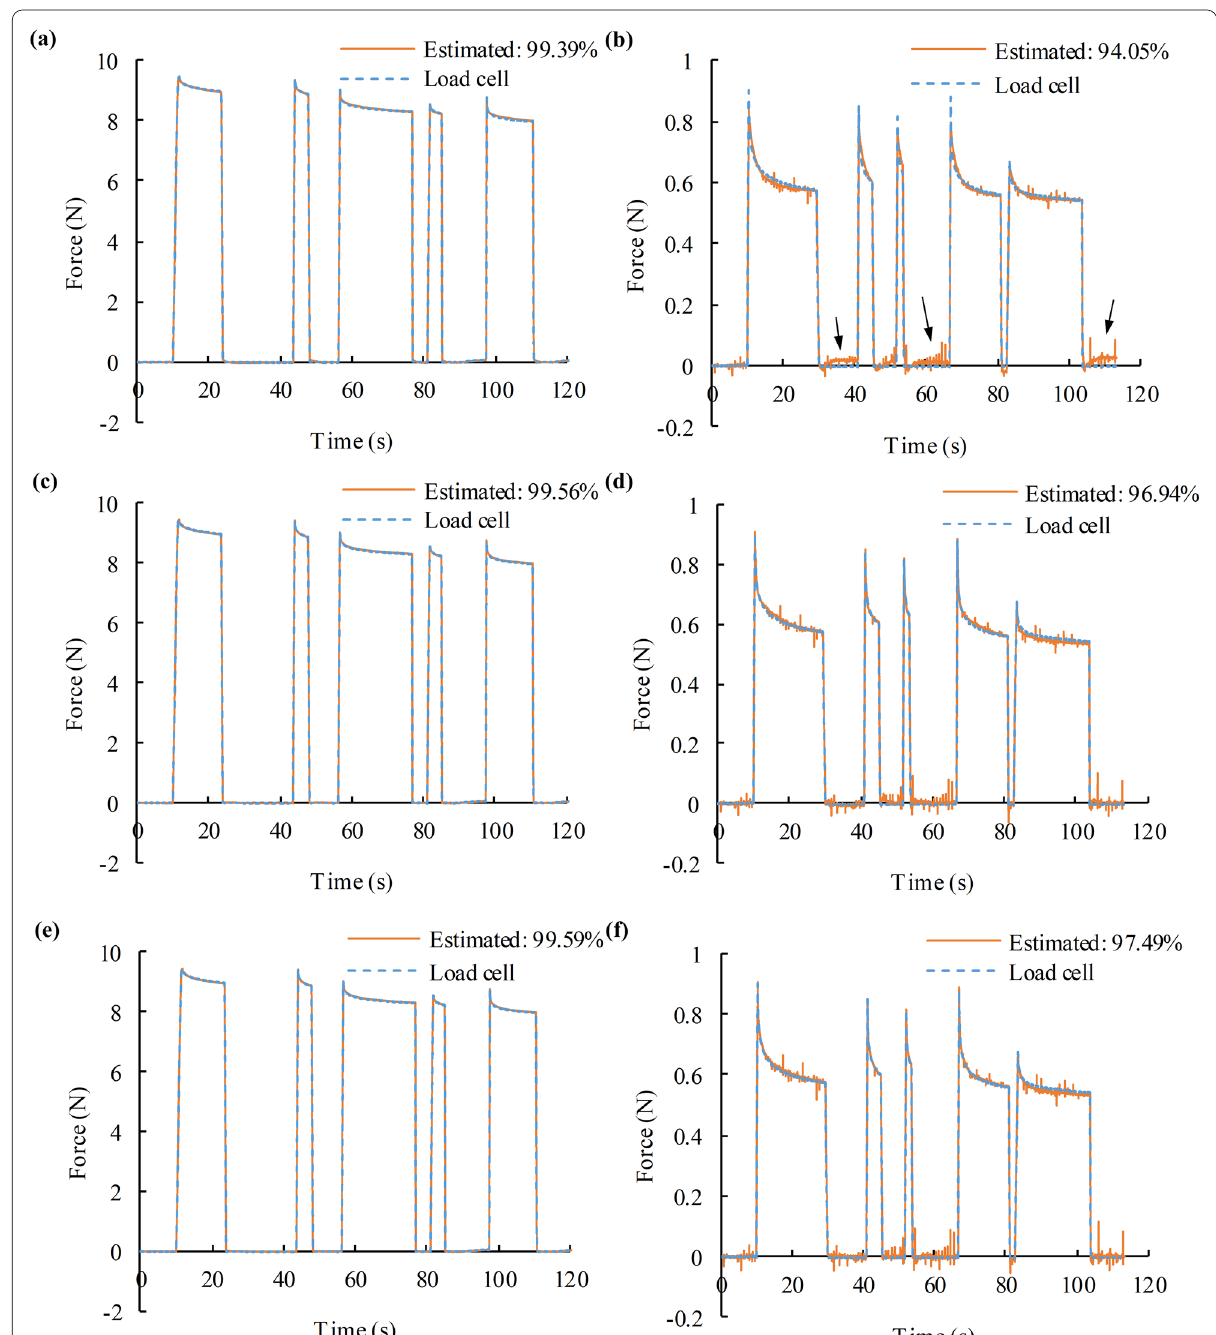
Fig. 9 Forces measured using prototype sensor and load cell when random force was applied (sample 1). FIT values are shown in each figure. a T < T g ( n 1). b T > T g ( n 1). c T < T g ( n 2). d T > T g ( n 2). e T < T g ( n 3). f T > T g ( n = = = = = =